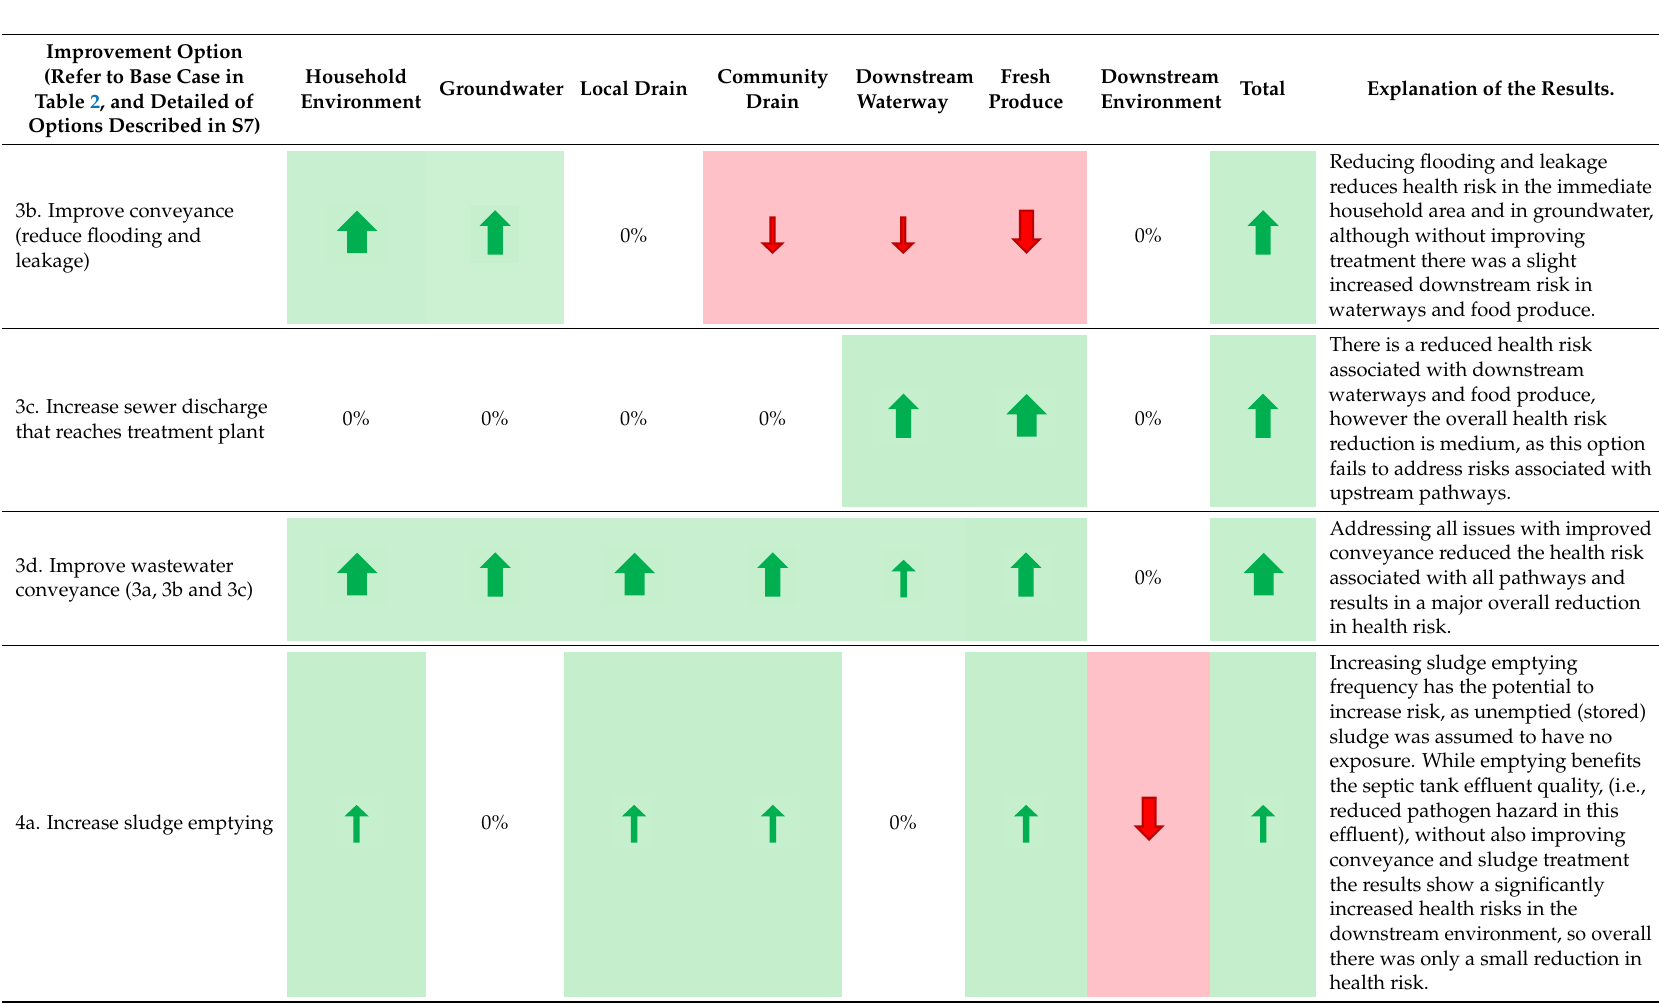
Table 3. Change in DALY per person per day from base case (based on exposure frequency and proportion of population exposed for Adults).